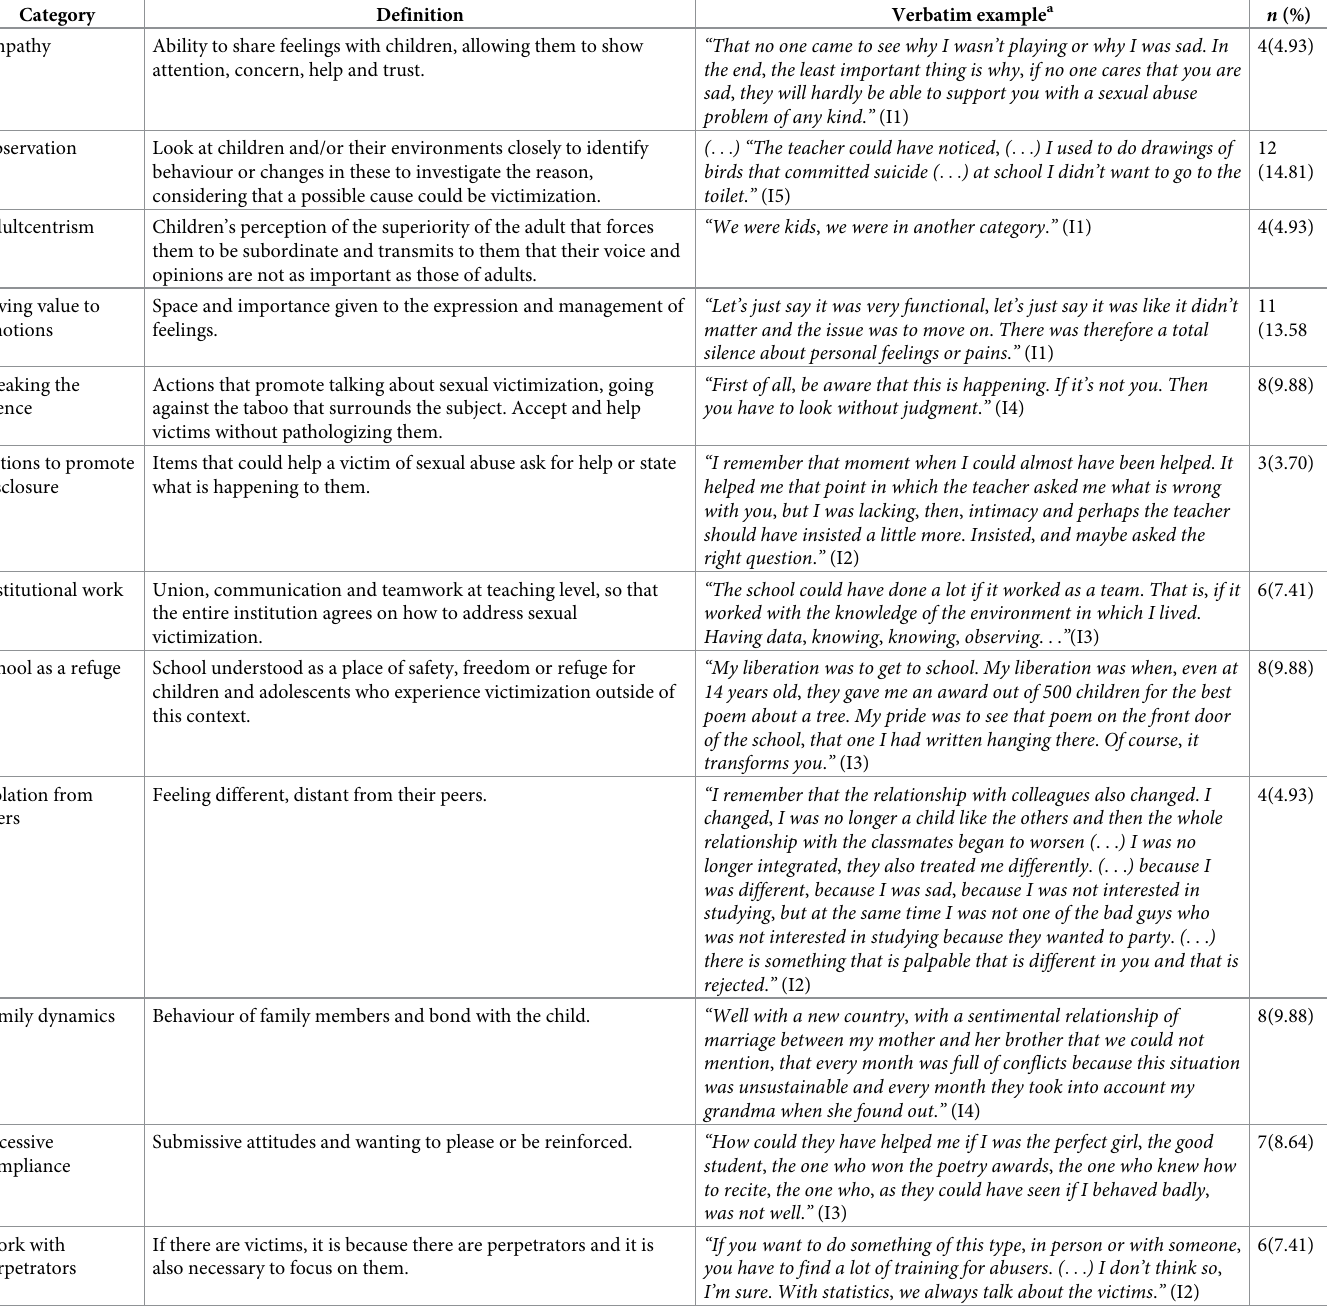
Table 3. Emerging categories to describe victims’ school